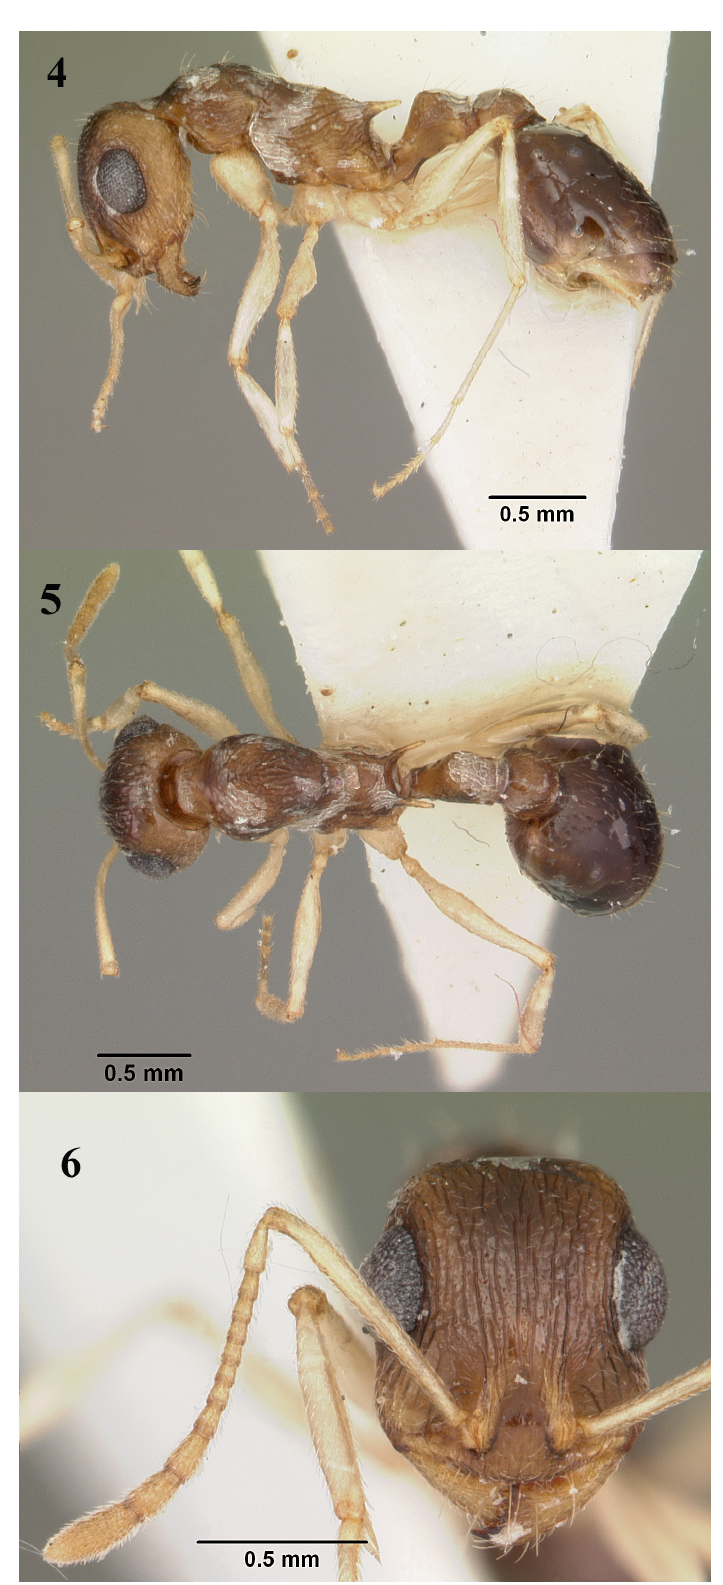
Figs 4–6 . Temnothorax liviae (Agosti & Collingwood, 2011) comb. nov., holotype, worker (CASENT0102700). 4 . Body in profile. 5 . Body in dorsal view. 6 . Head in frontal